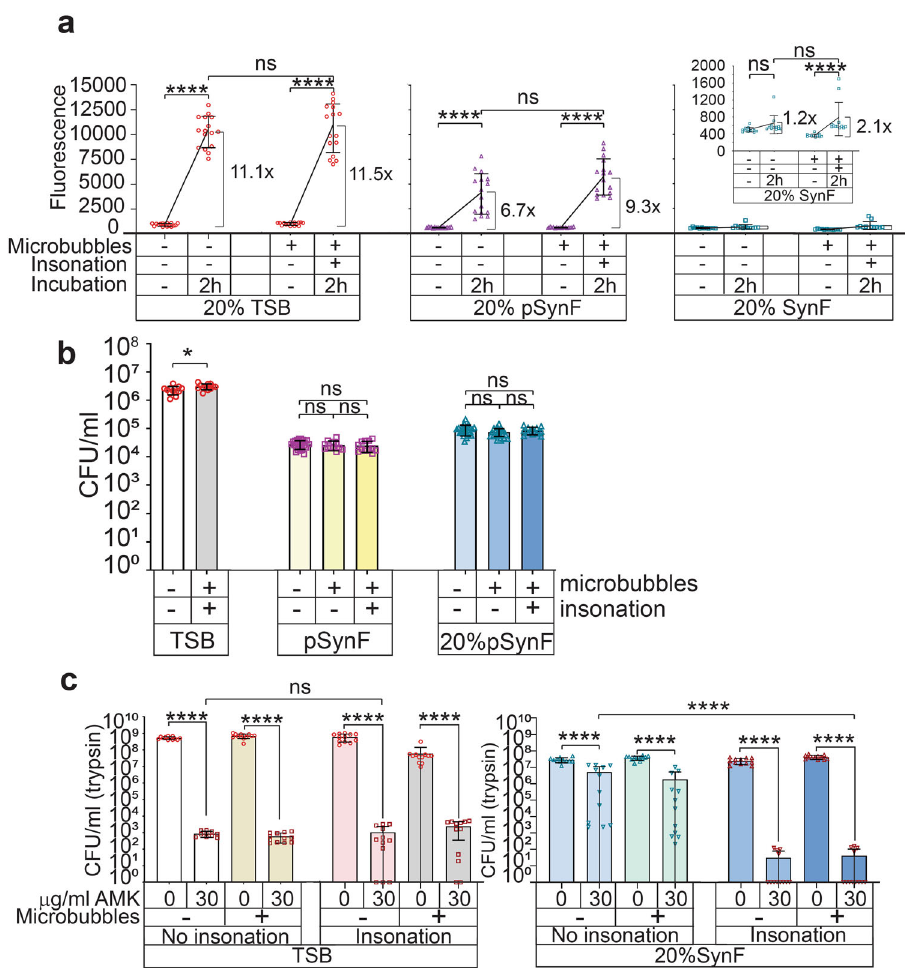
Fig. 4 Dilution and clinical ultrasound to disperse aggregates. a Metabolic activity, as indicated by Alamar blue fl uorescence, of S. aureus in 20% TSB, 20% pSynF, or 20% SynF with or without UTMD. Both 20% pSynF and 20% SynF showed an approximate doubling of metabolic activity after UTMD and 2 h incubation. b Dispersion measured as change in CFUs after application of clinical ultrasound, with or without microbubbles, to undiluted or diluted pSynF containing S. aureus aggregates. No changes in dispersal were measured. c AMK sensitivity of MSSA in TSB or 20% SynF as a function of microbubble addition and UTMD. Whereas TSB had 5 – 6 log decreases in recovered counts, independent of treatments, AMK sensitivity in 20% SynF cultures increased from an ~1 log decrease to a 6-log decrease with the application of ultrasound. Data are presented as mean ± standard deviation. For each bar a n = 12, b , n = 12, c n = 10 (TSB, no insonation, no microbubbles, AMK) or 11 (20% SynF, no insonation, no microbubbles, no AMK) or 12. Individual data points are shown as open, colored symbols. Normality checked using Kolmogorov – Smirnov test. Comparisons done using ( a , b (for pSynF, 20% pSynF)) Kruskal – Wallis test for multiple comparisons or ( b (for TSB), c ) Mann-Whitney tests for paired comparison on the basis of independent groups. ns, P > 0.05; * P < 0.05; ***P < 0.001; **** P <